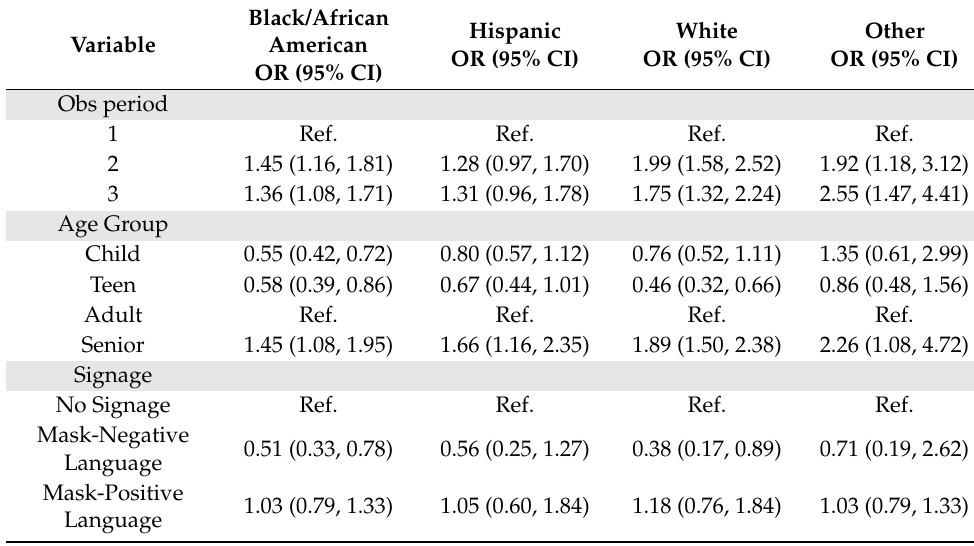
Table 4. Adjusted odds ratios for full masking, Stratified by Race/Ethnicity.